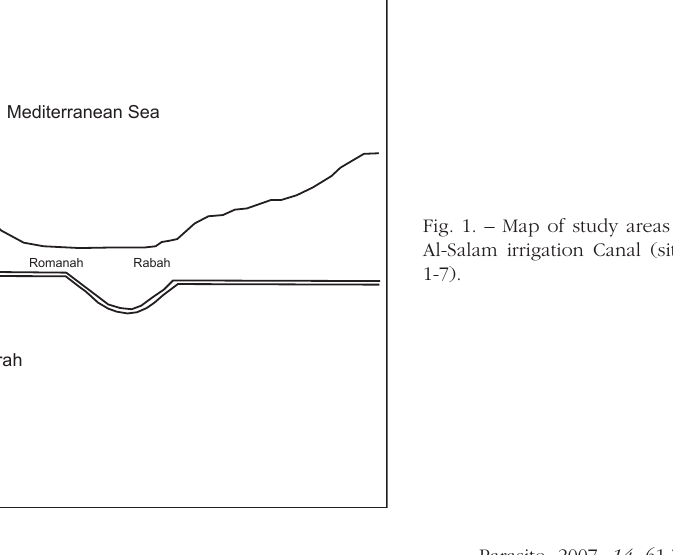
Fig. 1. – Map of study areas in Al-Salam irrigation Canal (sites